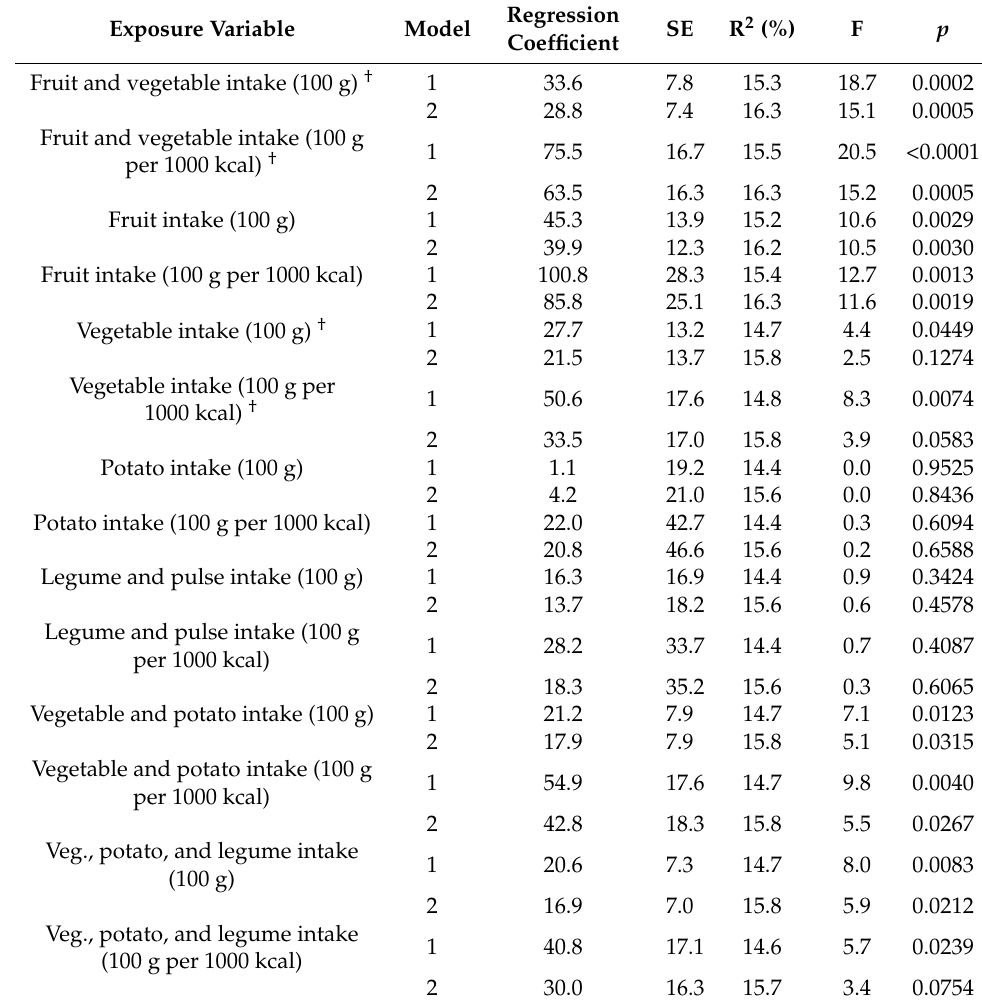
Table 3. Relationship between fruit and vegetable intake and telomere length in U.S. women